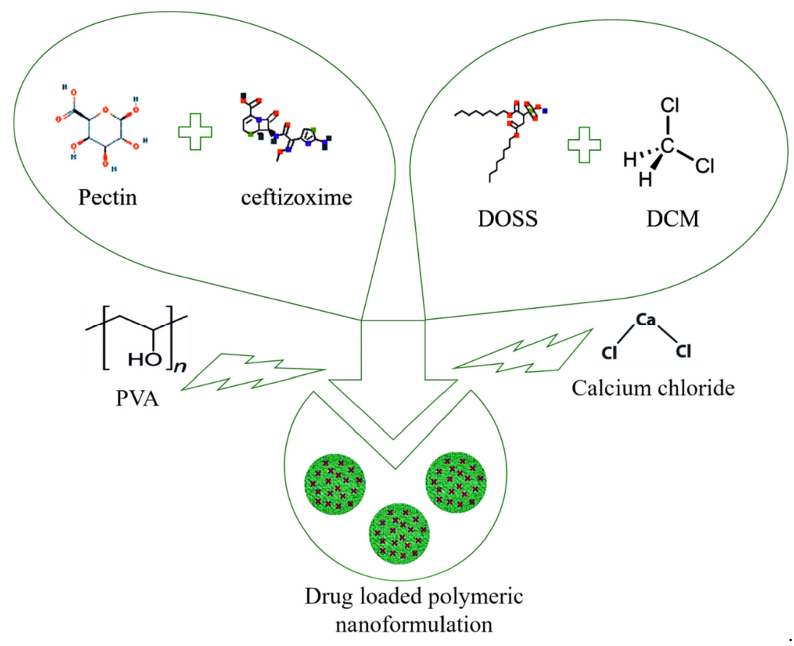
Figure 1. Schematic diagram of nanoformulation fabrication.